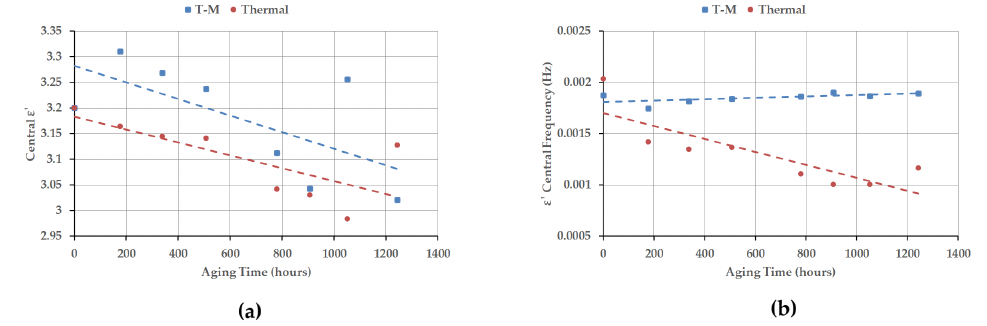
Figure 10. The calculated deducted quantities to characterize the ε (cid:48) ( f ) curves ( a ) central real part of permittivity ( CRP ); ( b ) real part of permittivity’s central frequency ( RPCF